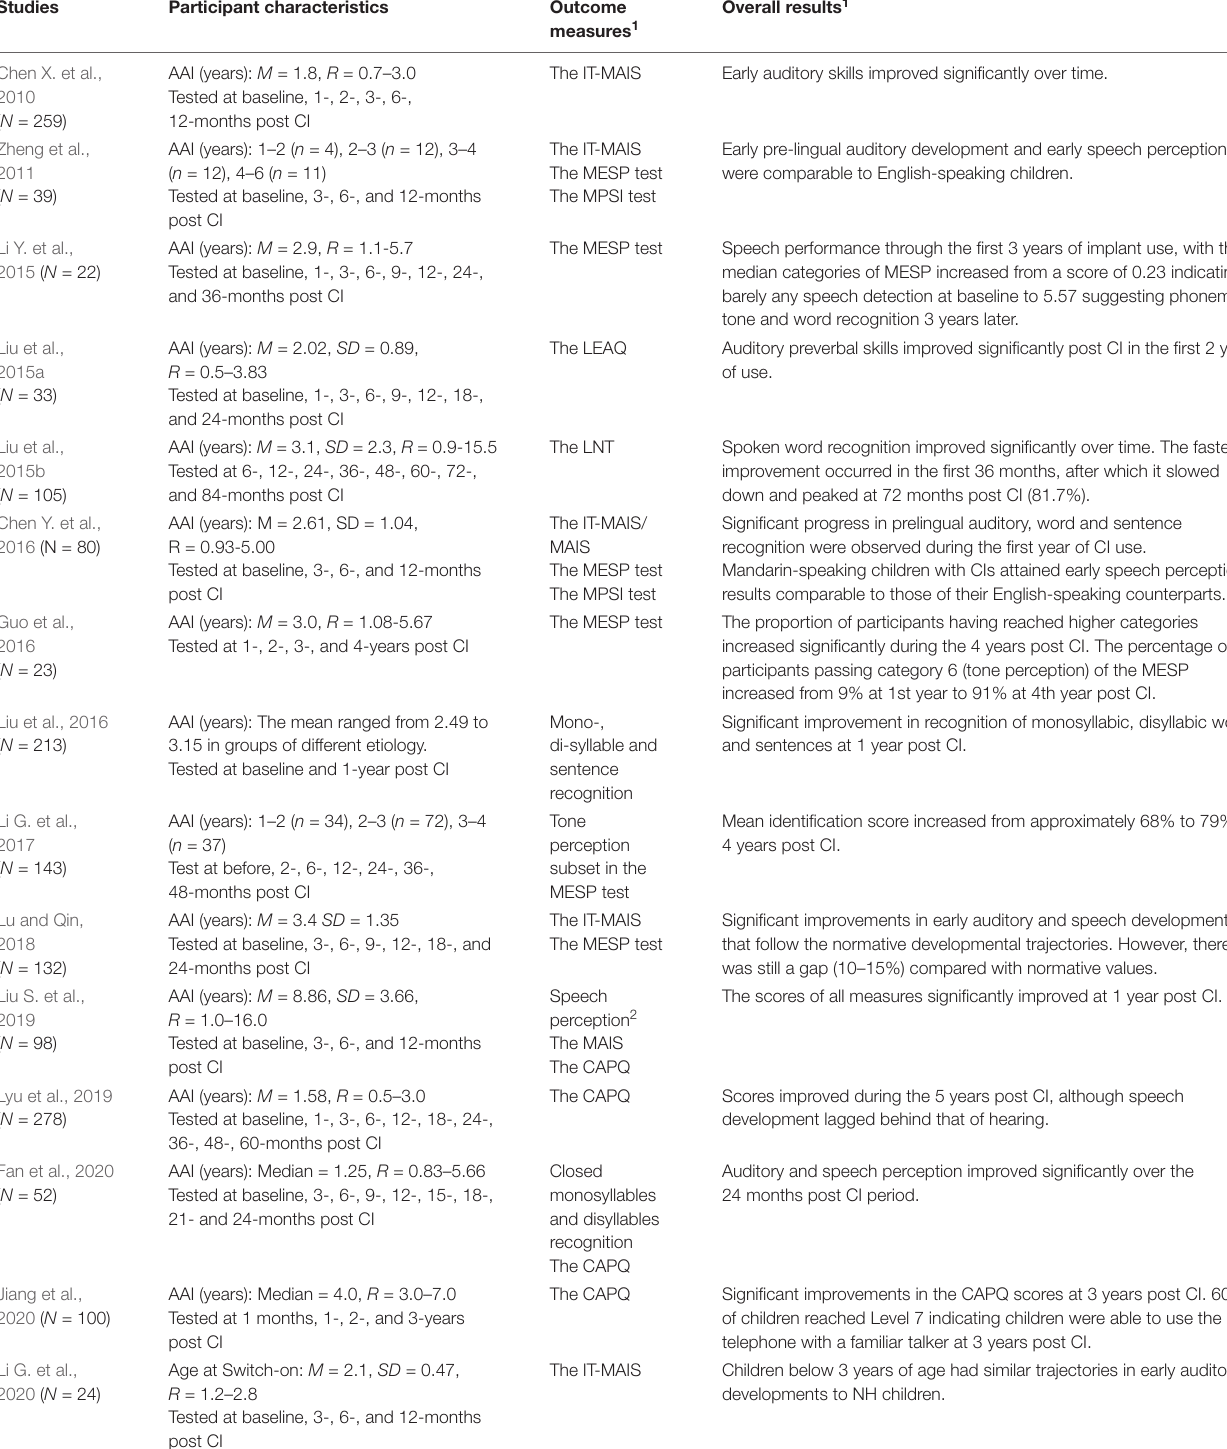
TABLE 3 | Longitudinal studies on speech perception with unilateral